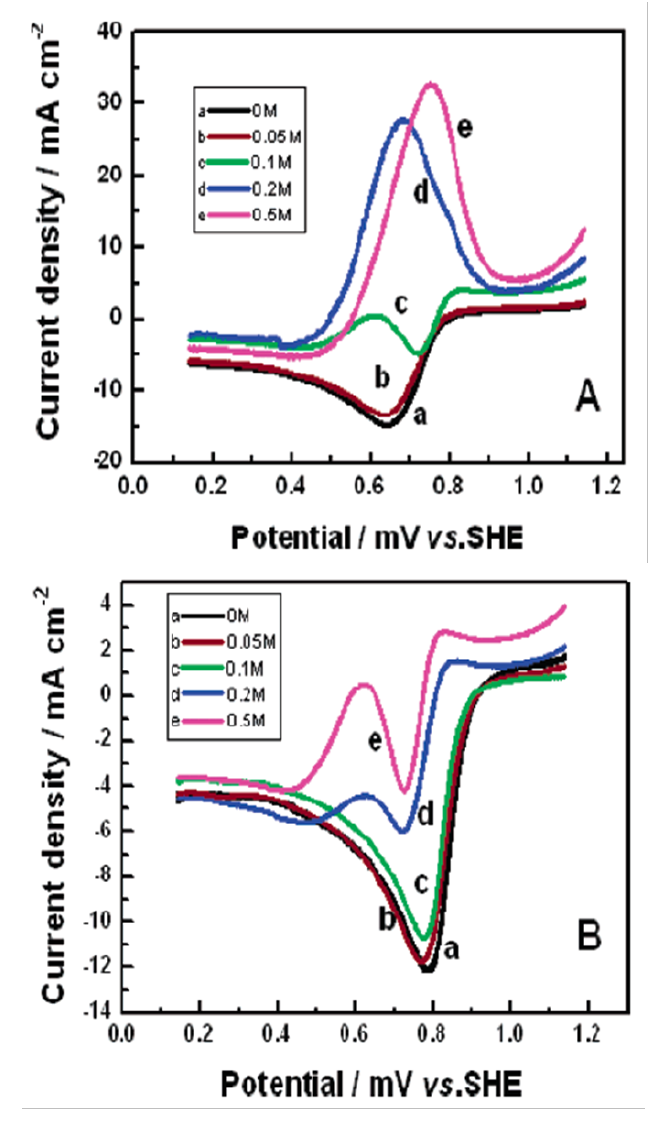
Figure 12. (A) CVs of ORR on Pt/C in an O methanol concentrations (B) CVs of ORR on Pt-W from Reference 100 with